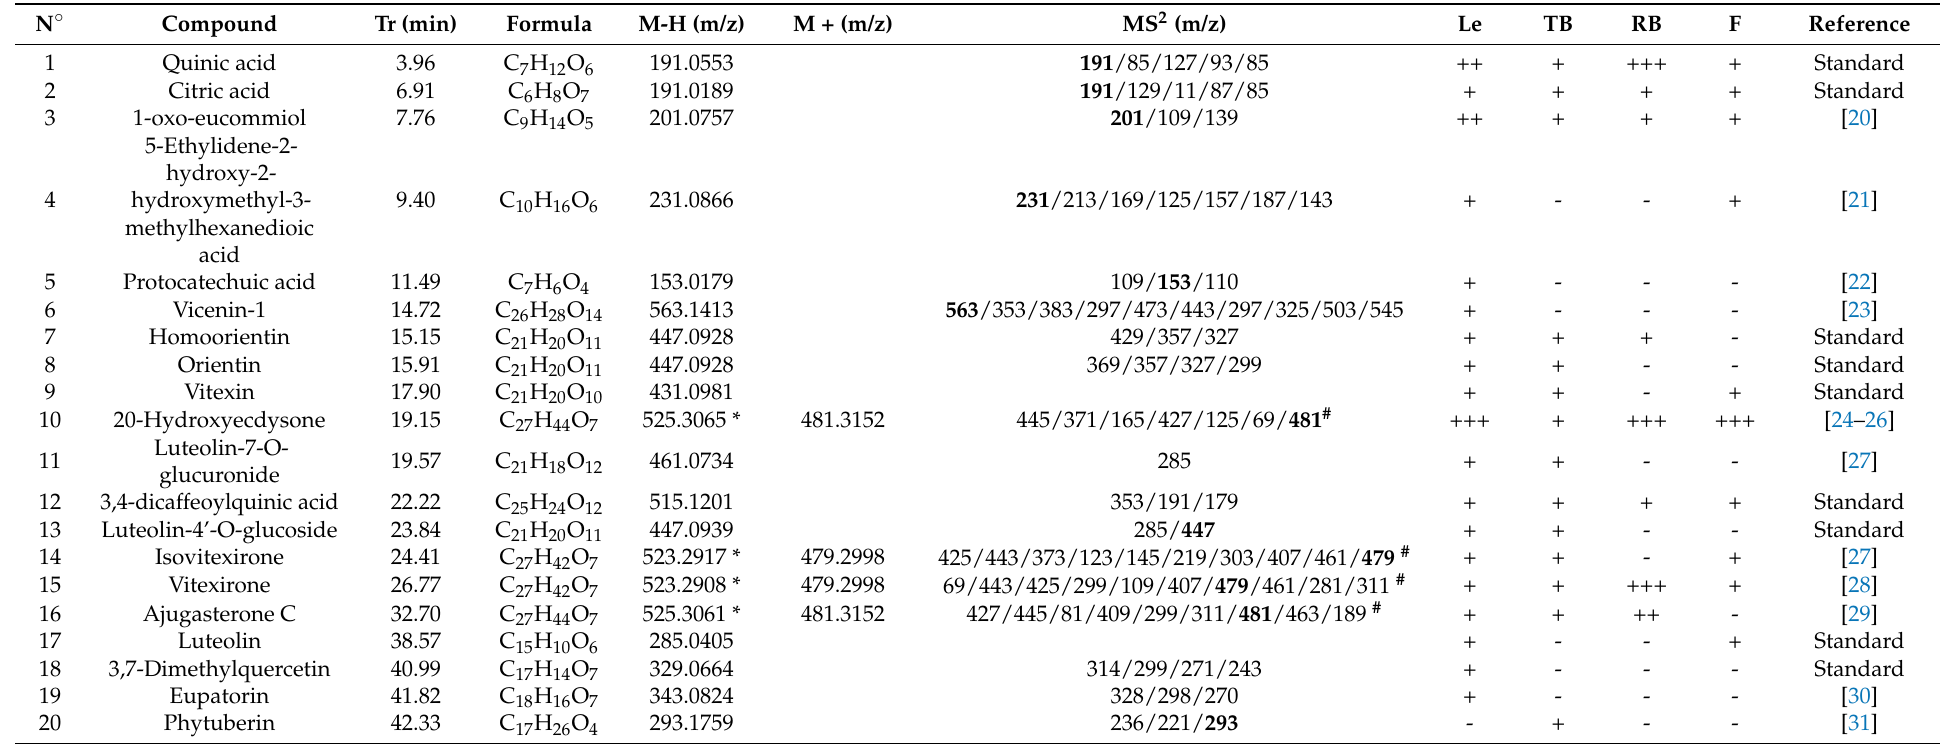
Table 1. Ecdysteroids and other compounds identified in extracts of leaves, trunk bark, root bark and fruits of Vitex madiensis